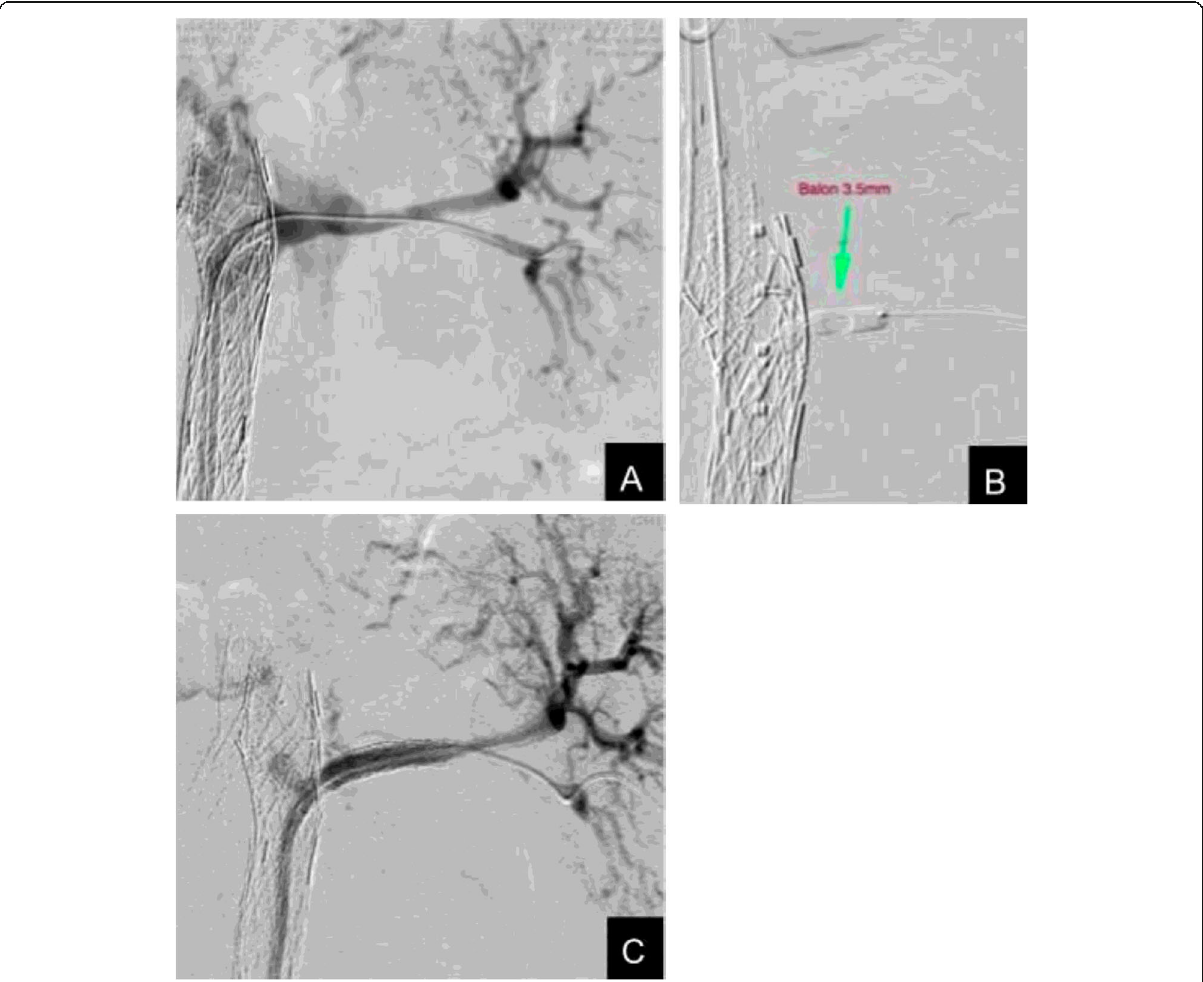
Fig. 2 a Control angiography through a guide catheter that shows MUG permeability with patent FL. b Balloon angioplasty for the opening of the membrane. c Angiographic control showing reconstitution of flow through the TL with complete sealing of the